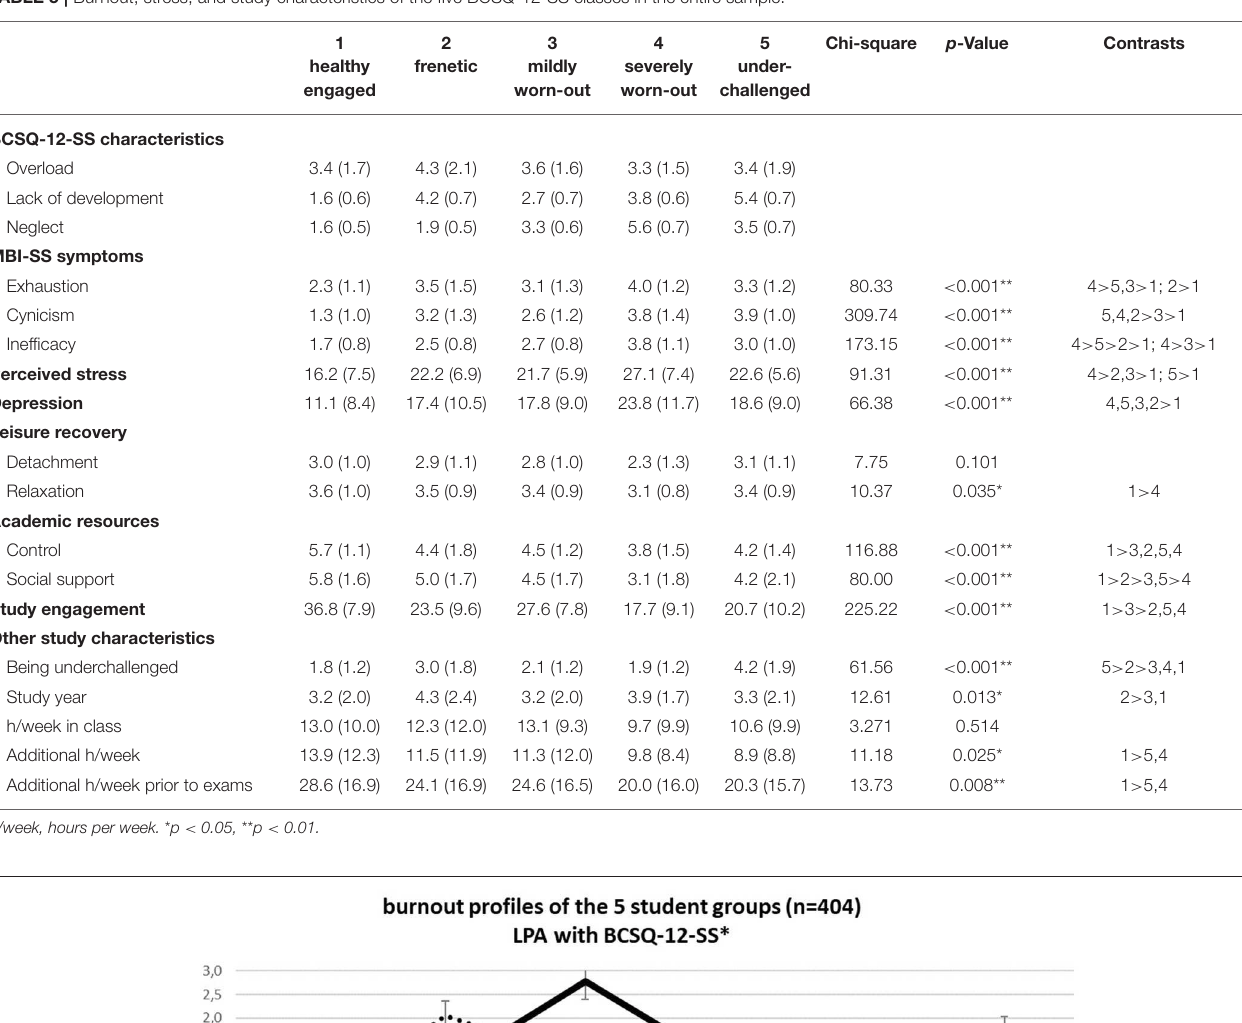
TABLE 5 | Burnout, stress, and study characteristics of the five BCSQ-12-SS classes in the entire sample.